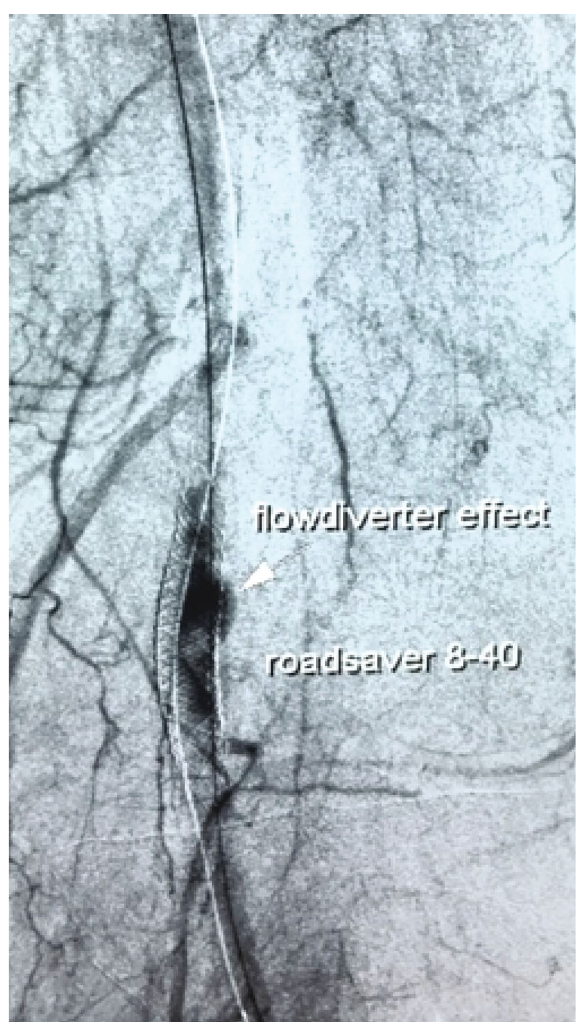
Figure 3: Flow diversion e ff ect after stent implantation: fl ow stagnation between the aneurism wall and the stent, corresponding to the grade C2 of the O ’ Kelly-Marotta